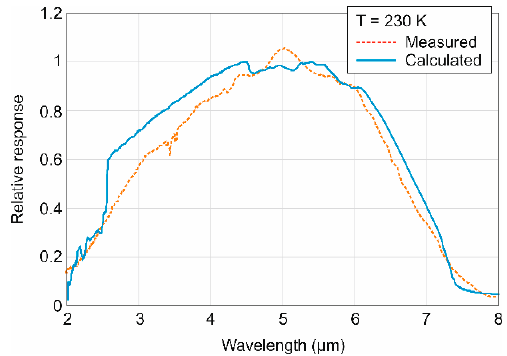
Figure 2. Measured (dotted line) and calculated (solid line) relative spectral response for the nBn T2SL detector.